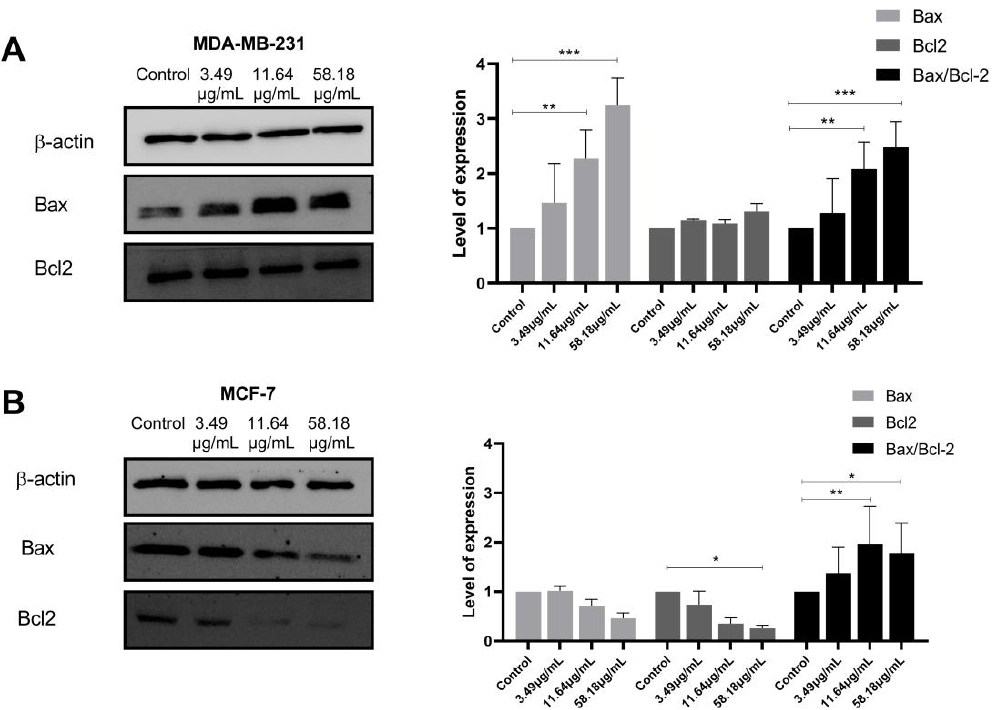
Figure 4. ScBEE activates the mitochondrial apoptotic pathway. Western blot analysis shows the upregulation of the Bax–Bcl2 ratio upon treatment of ( A ) MDA-MB-231 and ( B ) MCF-7 cells with increasing concentrations of the extract. Significant differences are reported; * indicates a p -value of 0.01 < p < 0.05, ** indicates a p -value of 0.001 < p < 0.01 and *** indicates a p -value of 0.0001 < p < 0.001. The full-length blots of all trials are reported as Supplementary Figures S3–S6.